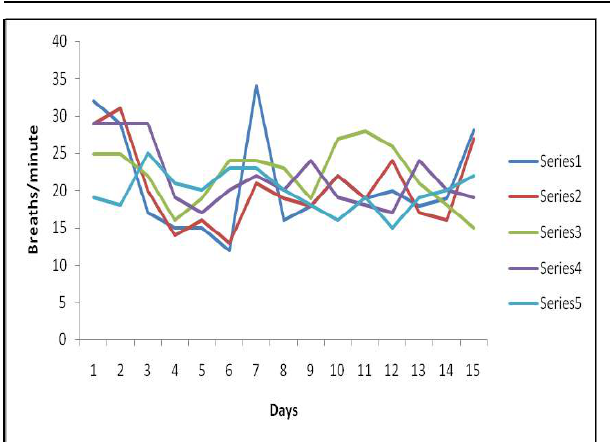
Figure-3a. Respiratory rates of dogs in Group A (Control) Figure-3b: Respiratory rates of dogs in Group B (infected). Each point on the horizontal axis represent 2